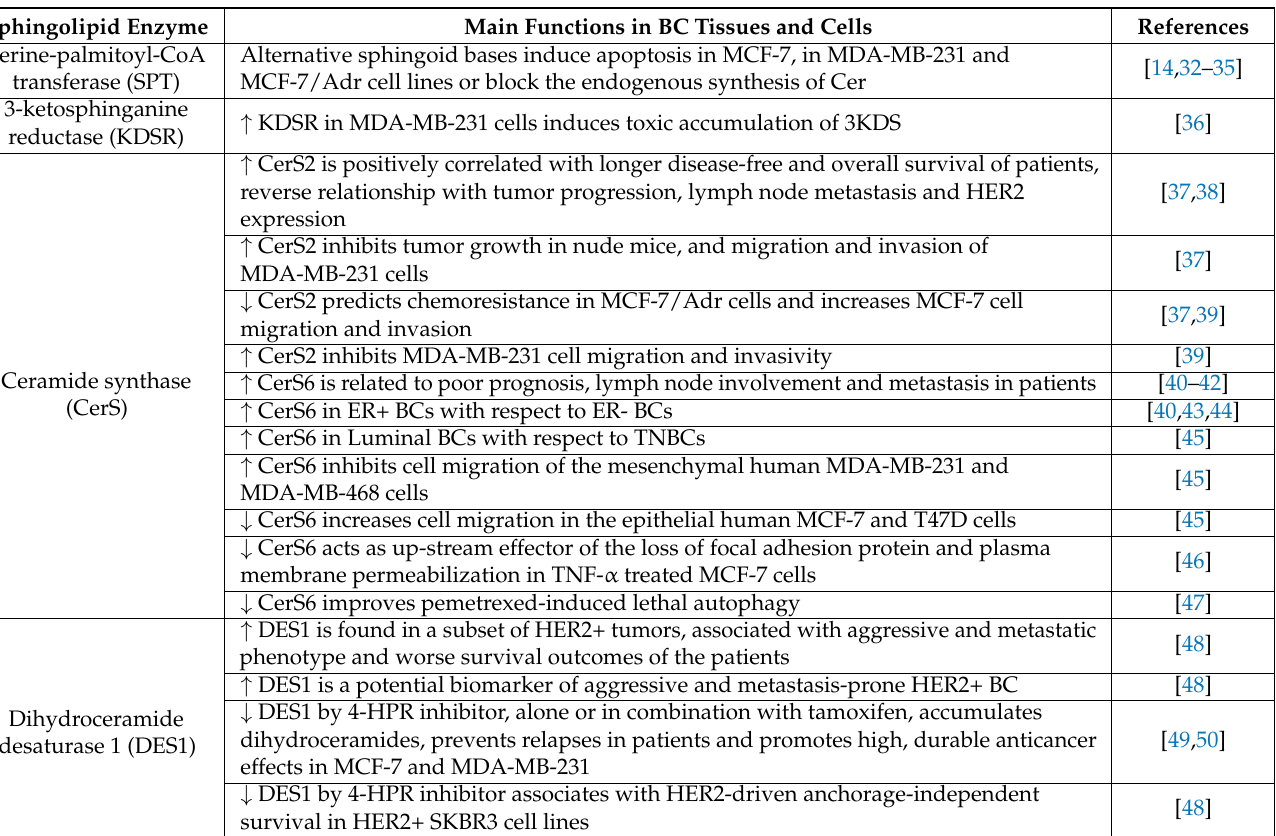
Table 1. Sphingolipid enzymes potentially involved in breast cancer growth and response to